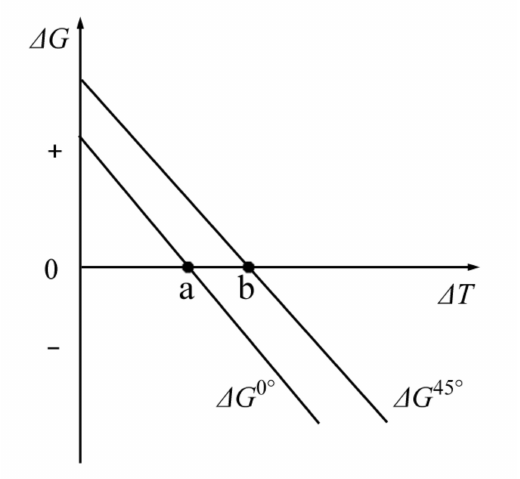
Figure 3. Variation of the free energy change ( ∆ G) with nucleation undercooling ( ∆ T) for 0 ◦ or 45 ◦ oriented growing α